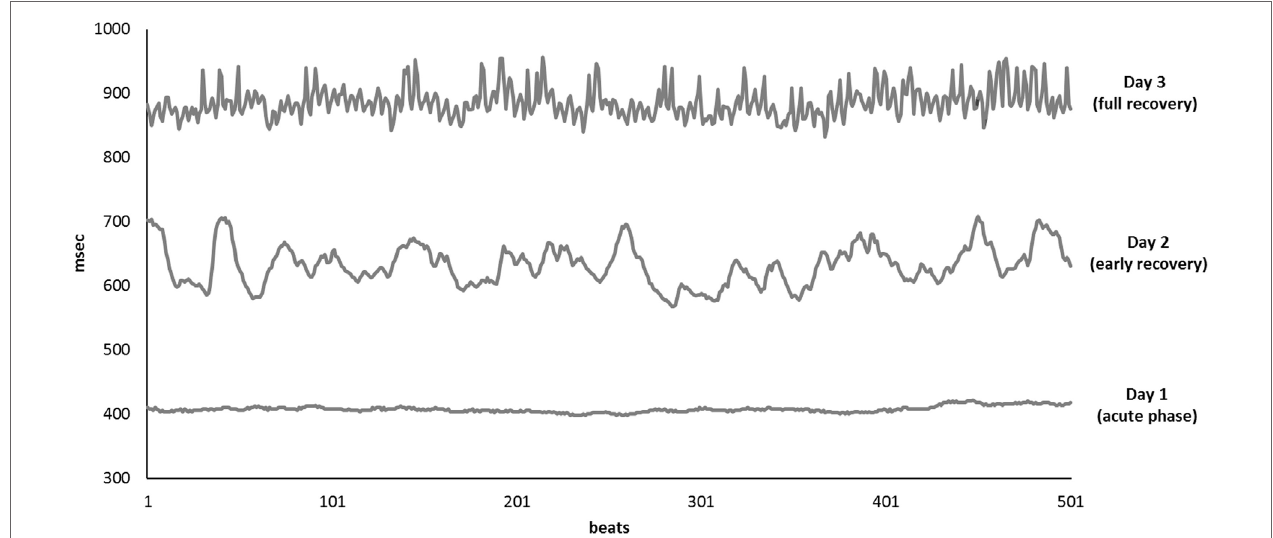
FIgURe 1 | Tachograms of 500 consecutive beats collected on Day 1 (bottom line), Day 2 (middle line), and Day 3 (upper line).